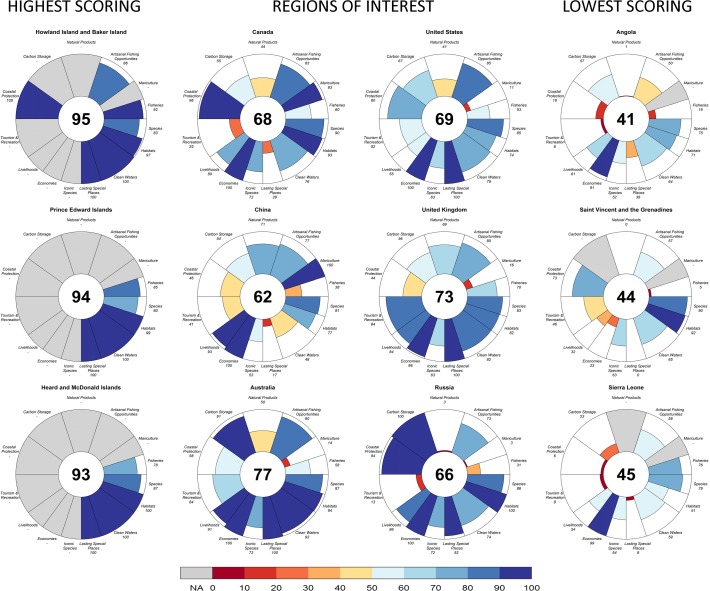
Index and goal scores for representative countries and territories for 2013.Examples shown include three of the top five highest-scoring regions in the world, the three lowest scoring regions, and regions of potential interest.